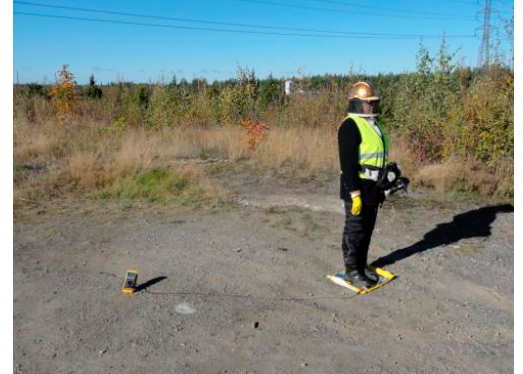
Figure 3. Test subject using the helmet–mask measuring system.